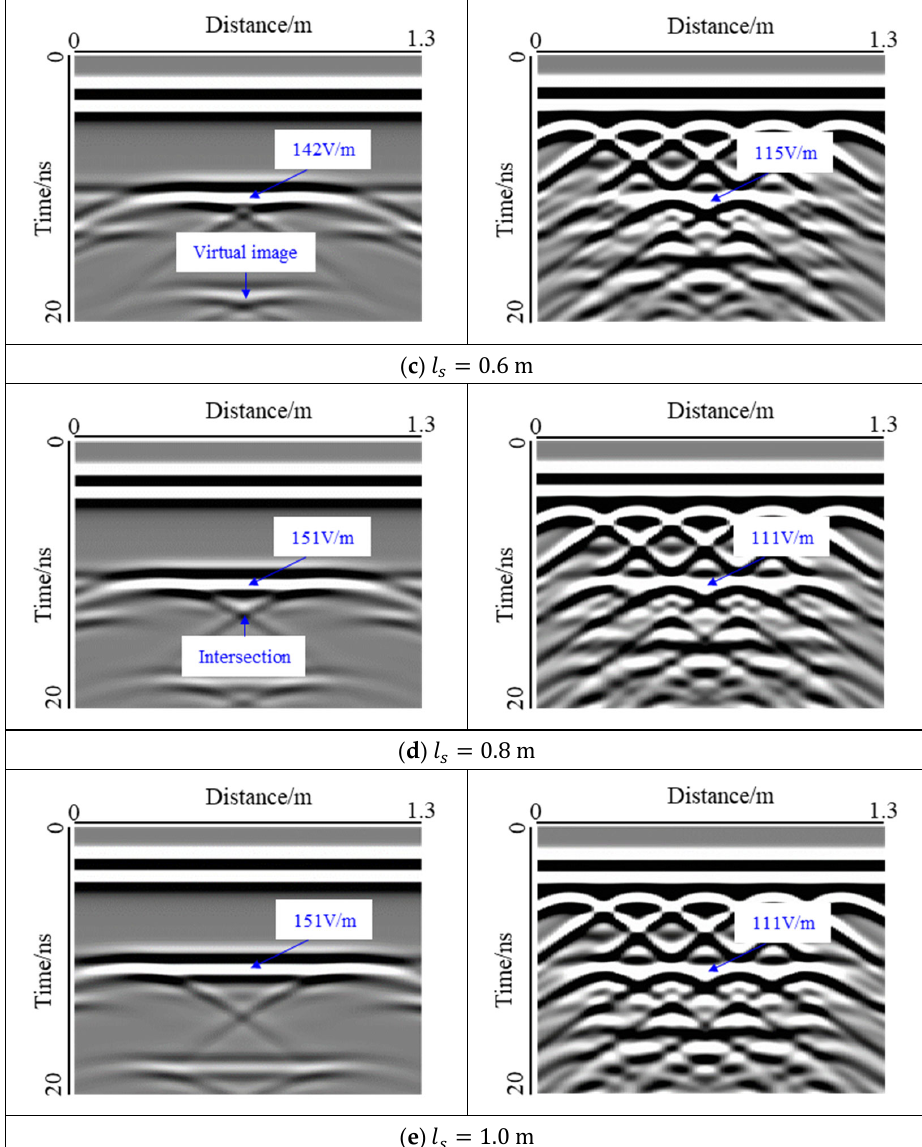
Figure 9. Influence of an air-filled void width at interface I. The increase in the void width caused the change in the response mode, and the interface Ⅱ was gradually covered by the void response.